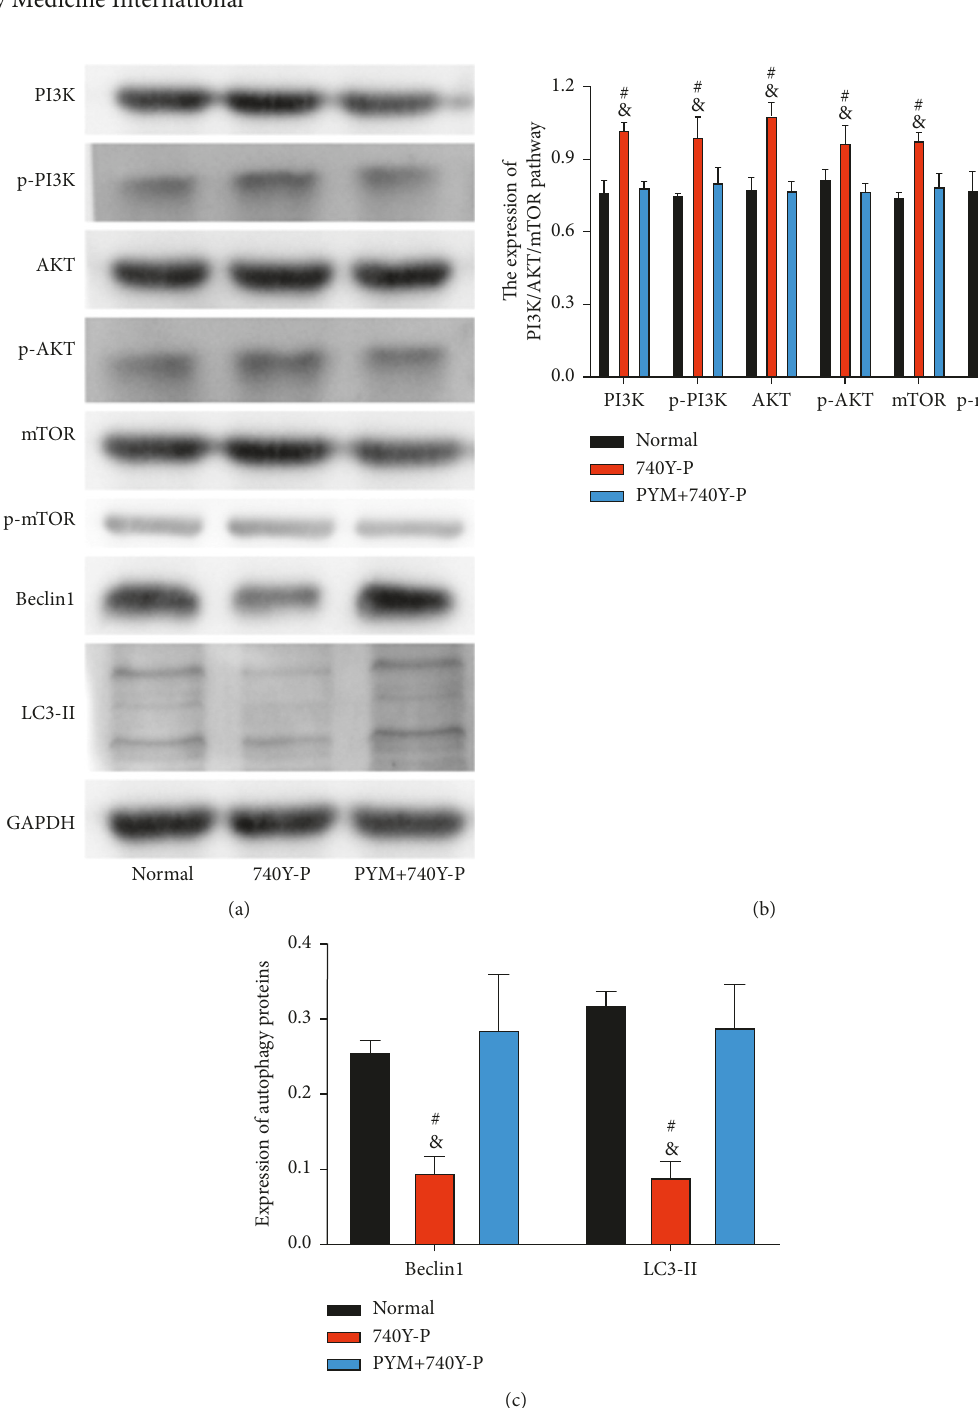
0 . 05; compared with the PYM+740Y-P group, & P <